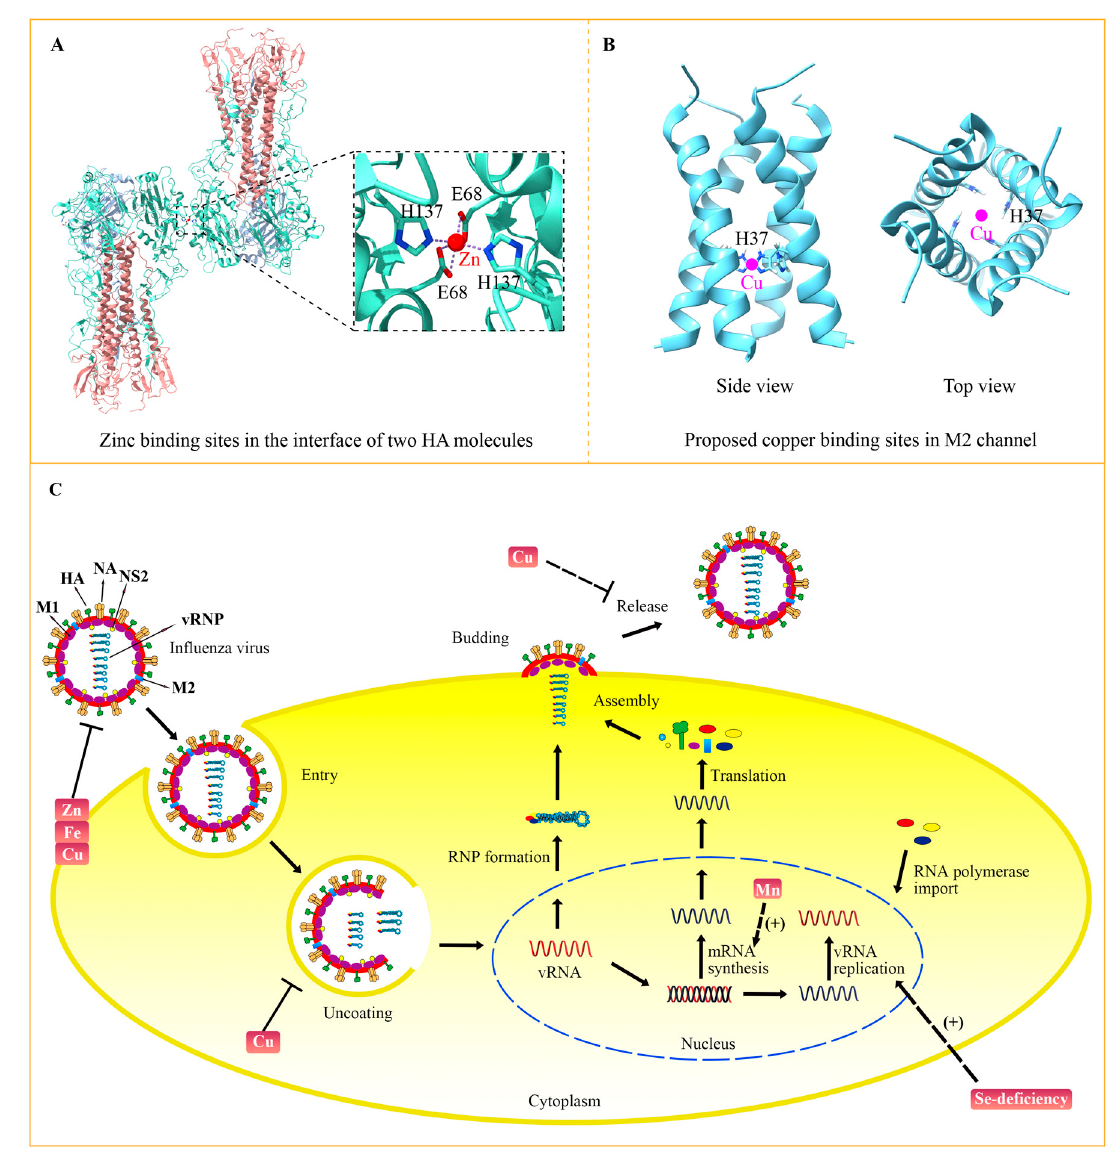
Figure 3. The targets of trace elements for the influenza virus. ( A ) Zinc resides in the interface of the HA proteins with the participation of two Glu68 and two His137 (PDB: 6LKS) [66]. A zinc ion is indicated with a red circle. ( B ) Copper is predicted to bind to His37 at the transmembrane domains of the influenza M2 channel. The proposed model is based on the NMR structure of M2 (PDB: 2KQT) [68]. The pink circles indicate copper ions that are predicted to reside in the center of the channel. ( C ) Influenza virus life circle and the targets of trace elements. The influenza virus enters the cell by endocytosis. The acidification in the endosomes promotes the uncoating process and releases viral RNPs into the nucleus. The viral gene was transcribed and replicated to produce mRNA and new viral RNA (vRNA) by the RNA polymerase complex. Then, viral mRNA is transported to the cytoplasm and translated into viral proteins, which are assembled into new viral RNPs with vRNA. The newly assembled virus is released from the host cells at the budding sites after sialic acid residues are cleaved by NA. Functions and targets of trace elements in viral life cycle are